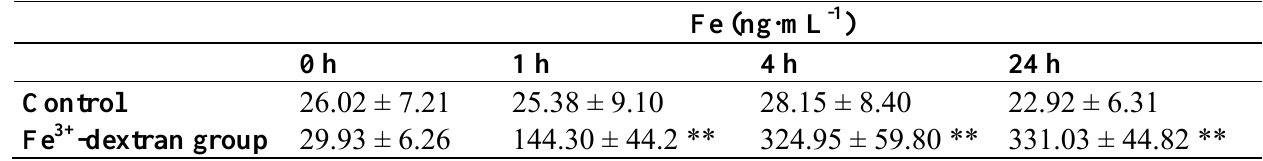
Table 1. Iron concentrations (mean ± S.D.) in serum of piglets (** p < 0.01), S.D.-standard deviation.